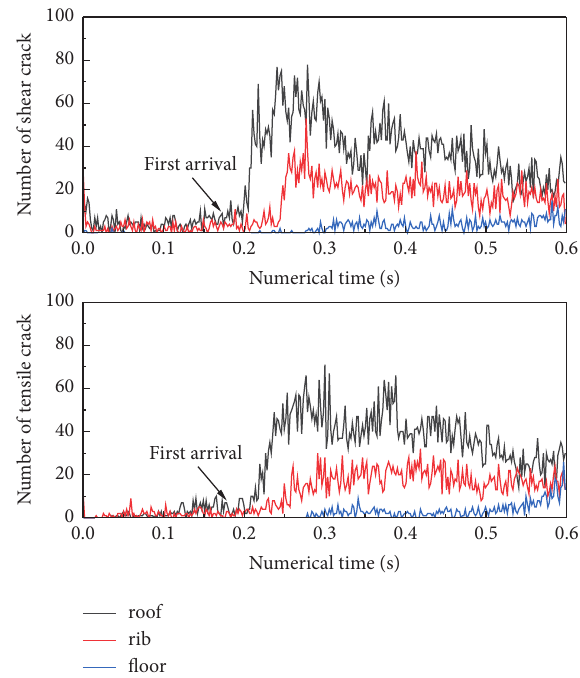
Figure 10: Variation of crack number with mine earthquake disturbance.